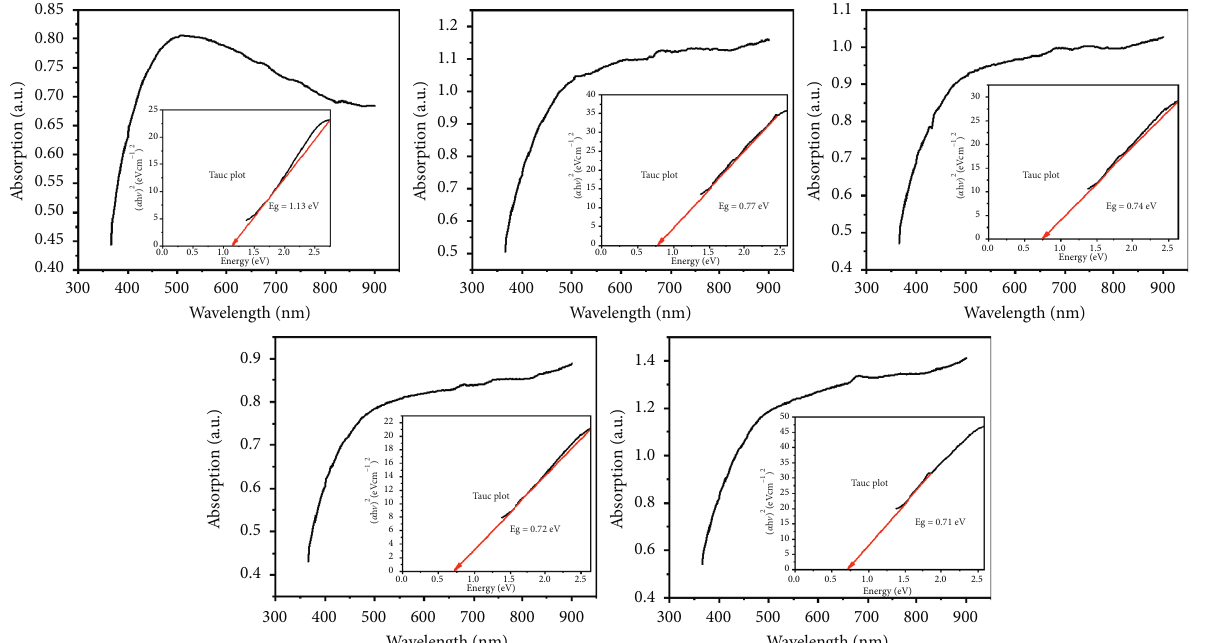
Figure 4: UV pattern of lanthanum-doped manganese barium hexaferrite Ba